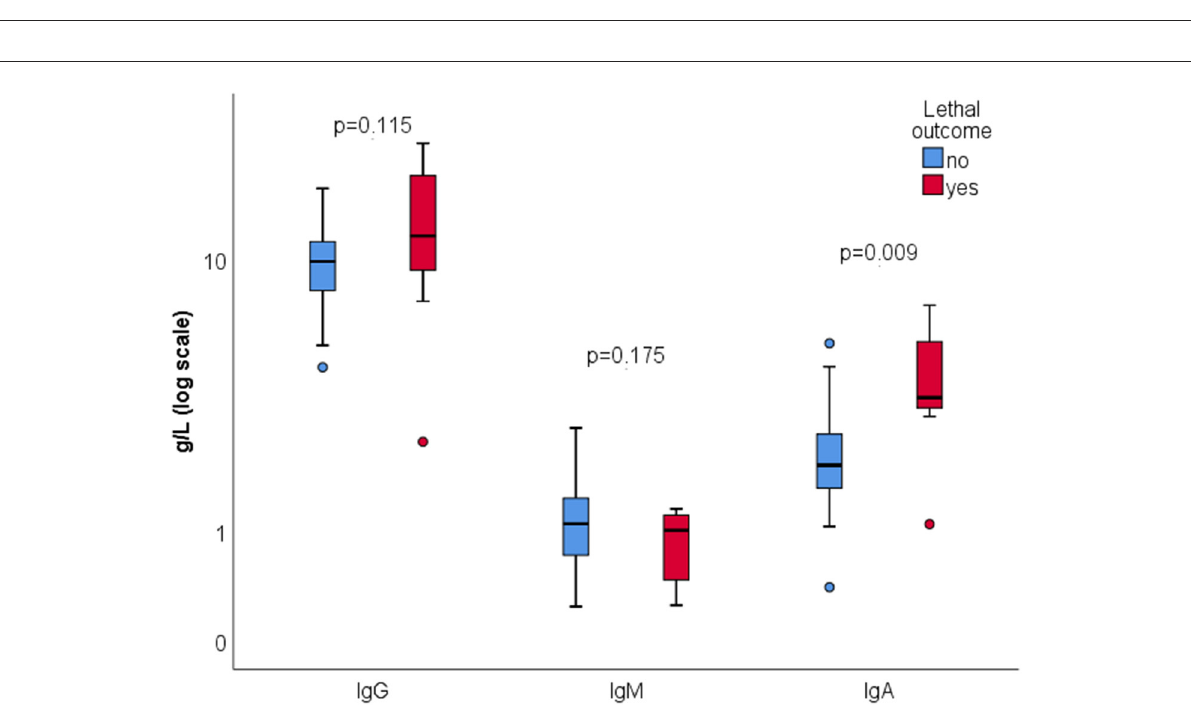
FIGURE3 Total serum immunoglobulins according to the